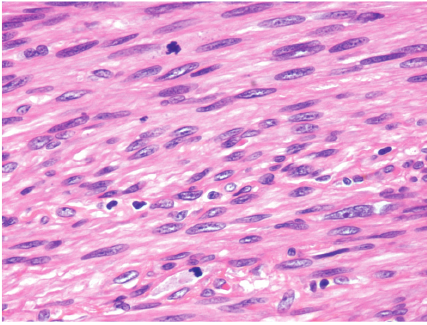
Figure 3: H&E section. Atypical mitoses.